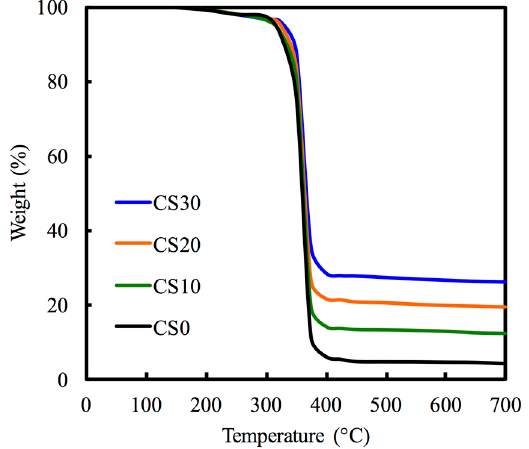
Figure 3. TGA curves of different Mg–CS/PCL scaffolds.